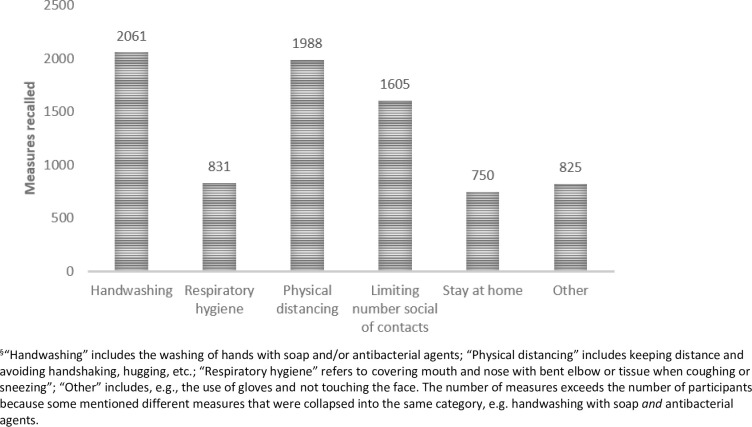
Count of health protective measures recalled§.